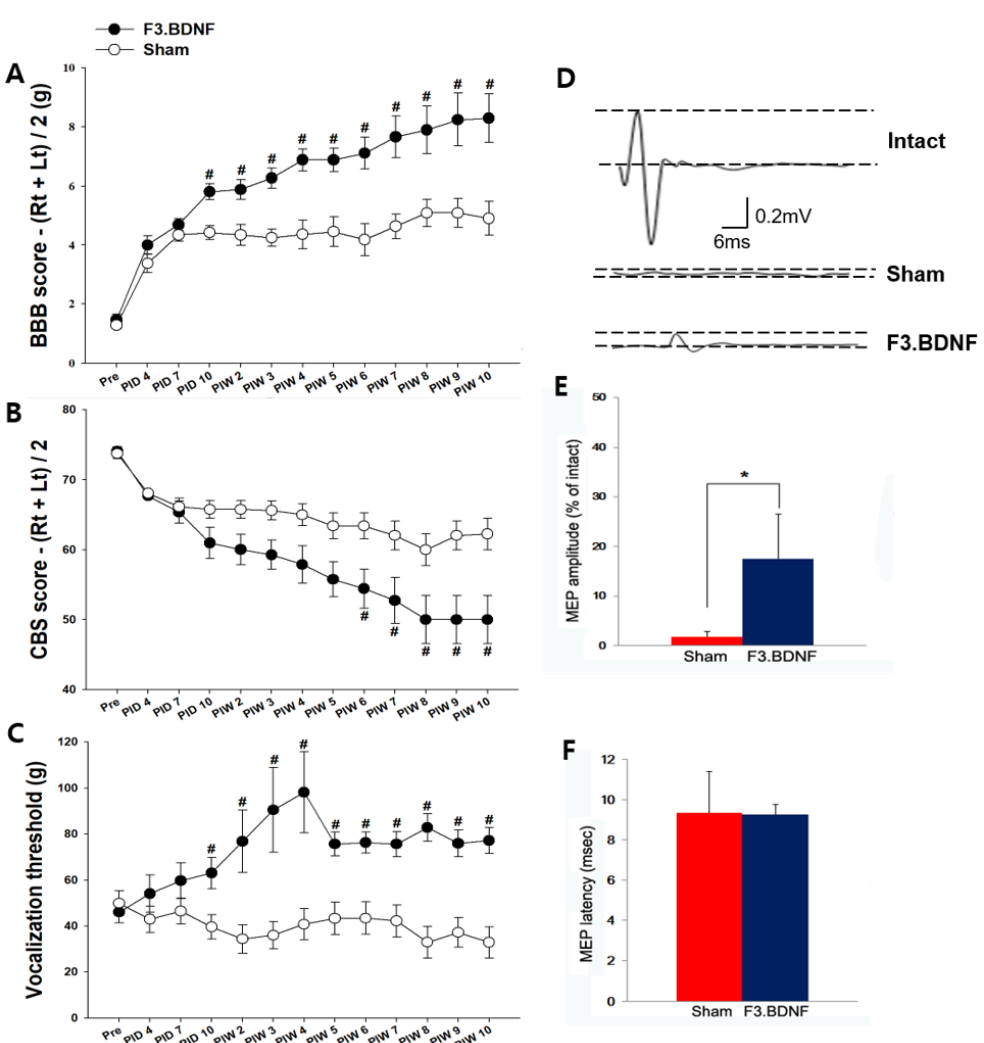
Figure 6. Transplanted F3.BDNF promoted motor functional and electrophysiological recovery after SCI. ( A ) Motor function in the hindlimbs was assessed by the BBB scores up to 10 weeks post-SCI. ( B ) Neurological assessment of functional deficit was measured by CBS test up to 10 weeks post-SCI. ( C ) Pain-related behavior was measured in vocalization threshold using Von Frey filaments in response to a rat mechanical stimulus applied to the back skin. The functional behavioral tests in the F3.BDNF group ( n = 13) were significantly higher than that in sham group ( n = 13). Data are presented as means ± SEM. Behavioral tests were analyzed by three observers who performed the blind tests independently. ( D ) Electrophysiological analysis was performed 80 days after SCI. The right motor cortices were stimulated, and MEP amplitudes were recorded from the left hamstring muscles. The data of the MEP indicate the latency for the time of stimuli from the onset to peak and amplitude. MEP waves were detected in most of the F3.BDNF group, whereas they were not detected in the sham group. ( E ) Relative values of the mean MEP amplitudes. Values are expressed as percentages of those in the intact animals ( n = 3). Mean relative MEP amplitudes in the F3.BDNF group ( n = 4) was significantly higher than that in the sham group ( n = 3). ( F ) Relative values of the mean MEP latency. Mean relative MEP latency in the F3.BDNF group was not significantly different. *, p < 0.05; Data are means ± SD. Abbreviations: PID, post injury day; PIW, post-injury week. # p <